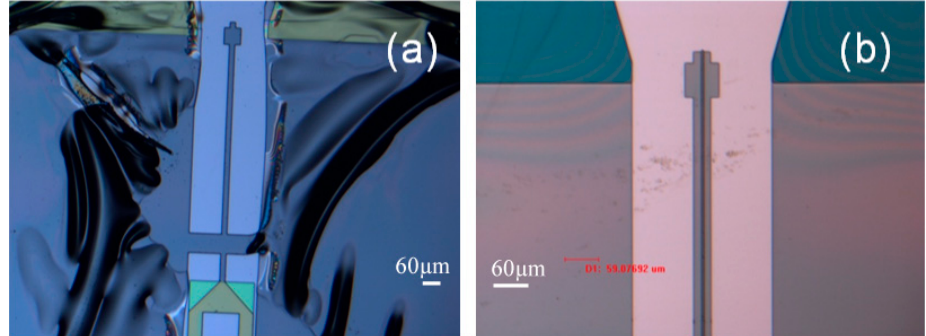
Figure 16. Lithographic result of double-layer SU-8 waveguide on nitride / silicon substrate. ( a ) Baking at lower temperature (65 ◦ C / 95 ◦ C) where large SU8 film area such as actuators appear to peel from the nitride surface ( b ) when operates at higher temperature (70 ◦ C / 105 ◦ C), SU8 film appears smooth and laminated.